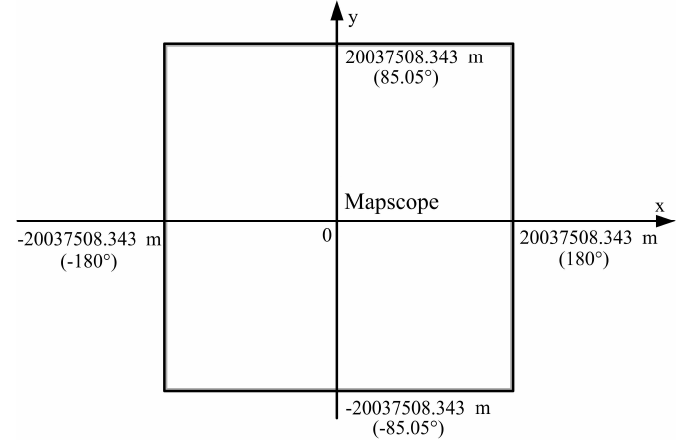
Figure 1. Scope of the square region in the PDF (portable document format) tile map pyramid model. The equator is the x-axis, and the prime meridian is the y-axis. The intersection point of the two is the origin of the coordinate, which is positive to the east and north, and negative to the west and south. Table 2. PDF tile map pyramid rule list.